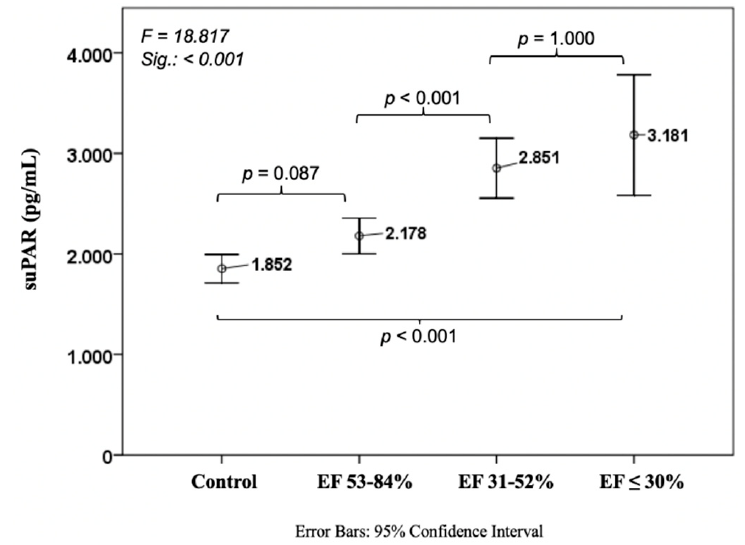
Figure 1. Course of soluble urokinase-type plasminogen activator receptor in ischemic heart disease. EF: ejection fraction; suPAR: soluble urokinase-type plasminogen activator receptor; EF: ejection fraction.